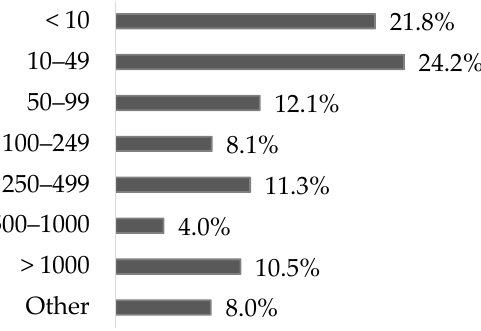
Figure 3. The total number of employees in the participant’s FM departments.